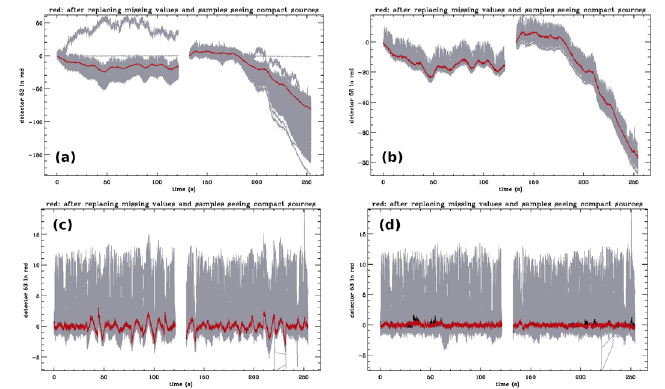
Figure 1. Time series of all detectors in grey, and of a particular detector in red at various steps: (a) initially ; (b) after correction for the relative gains and masking of bad detectors ; (c) after first baseline subtraction ; (d) after correction for the average drift on small timescales. In these plots, samples where a compact source is detected are replaced with simulated white noise.